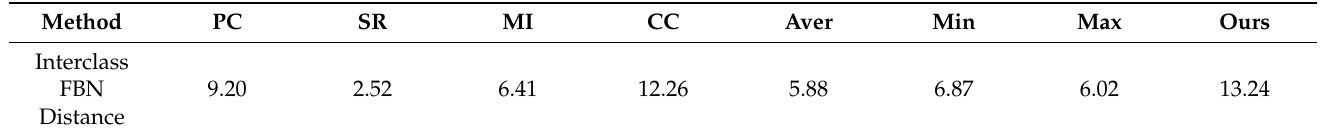
Table 2. Interclass FBN distance between ASD patients and normal controls based on different methods. Aver: averaging fusion; Min: minimization fusion; Max: maximization